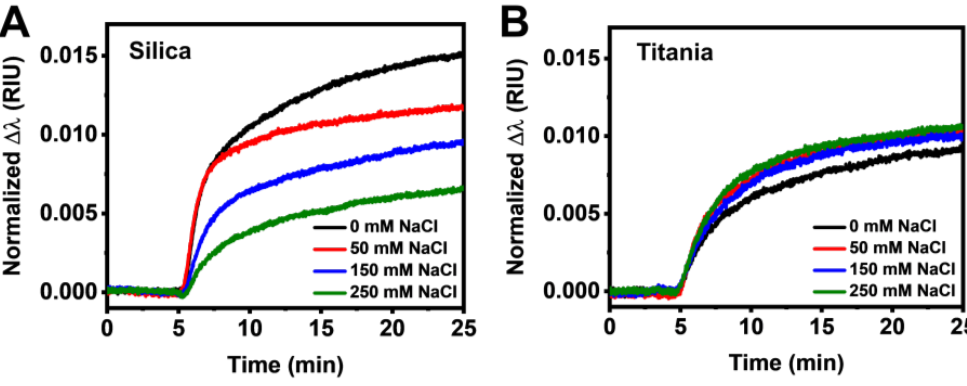
Figure 4. Normalized LSPR peak shift responses as a function of time for HSA adsorption onto ( A ) silica and ( B ) titania surfaces in 0, 50, 150, and 250 mM NaCl conditions.